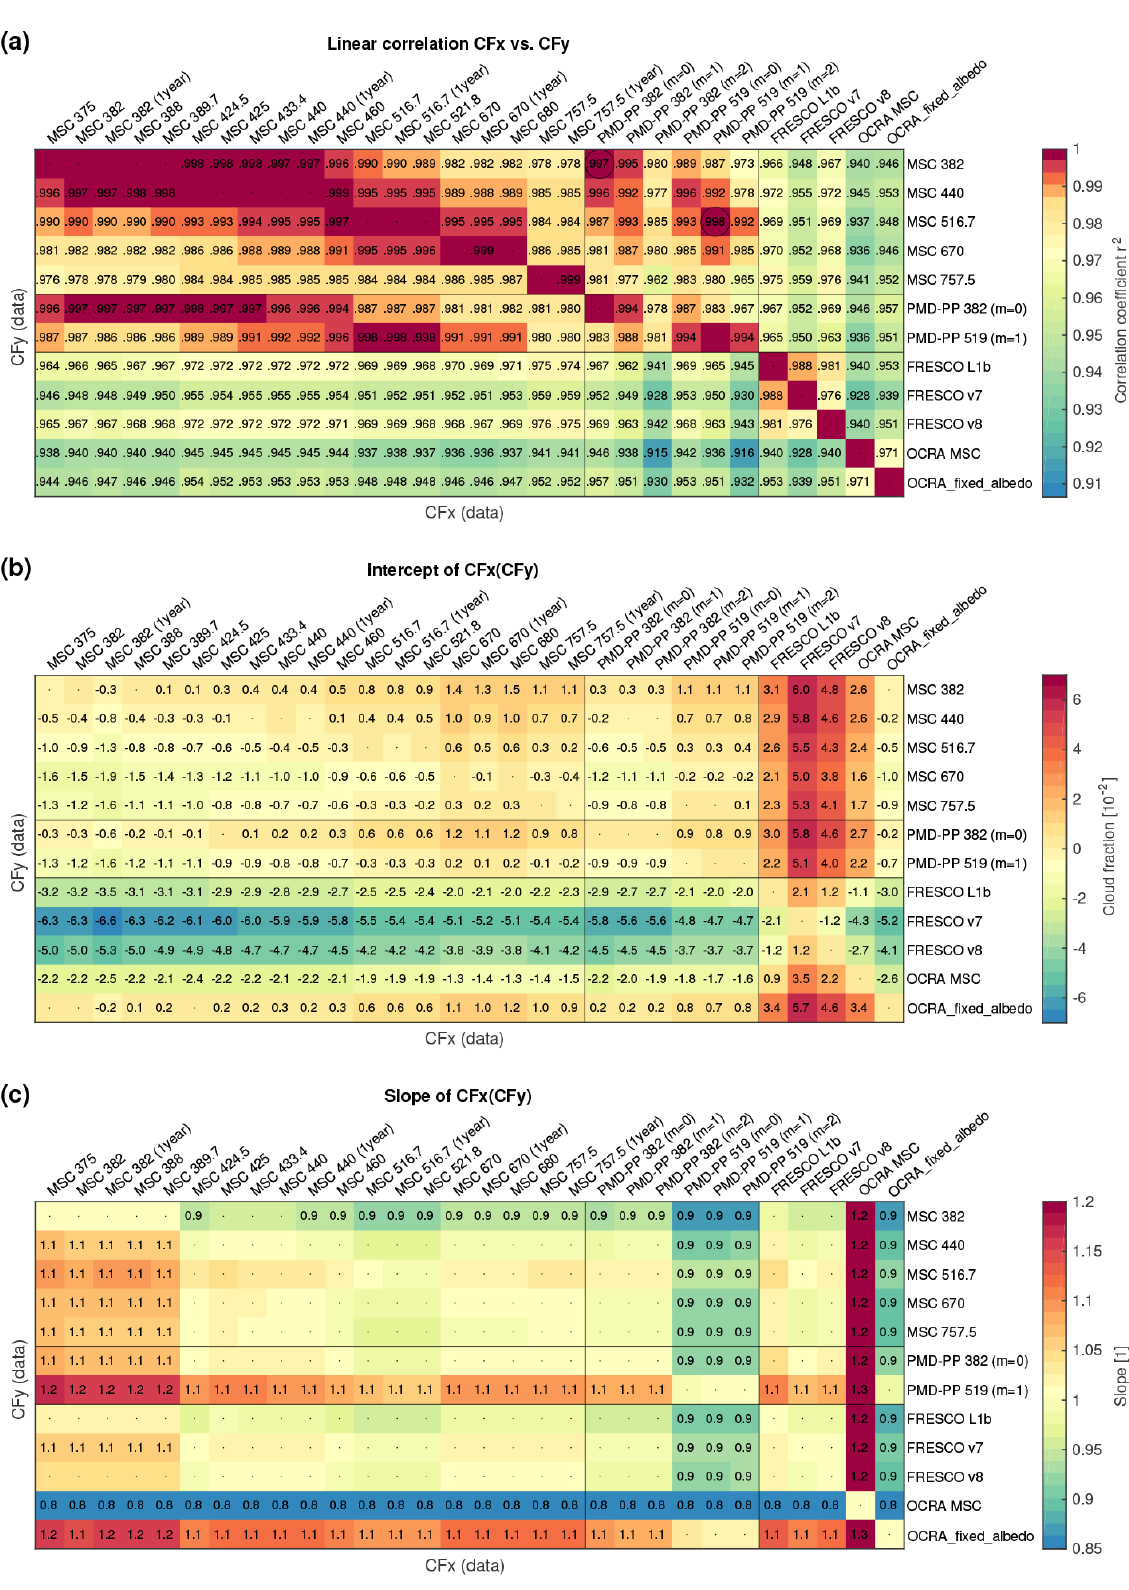
Figure E2. Continuation of Fig. E1: (a) linear coefficient of correlation r 2 , (b, c) intercept and slope of bi-variate linear fit, respectively. Numbers of small deviations from 0 and 1, respectively, are omitted for the sake of clarity. The circled values in panel (a) correspond to Fig.